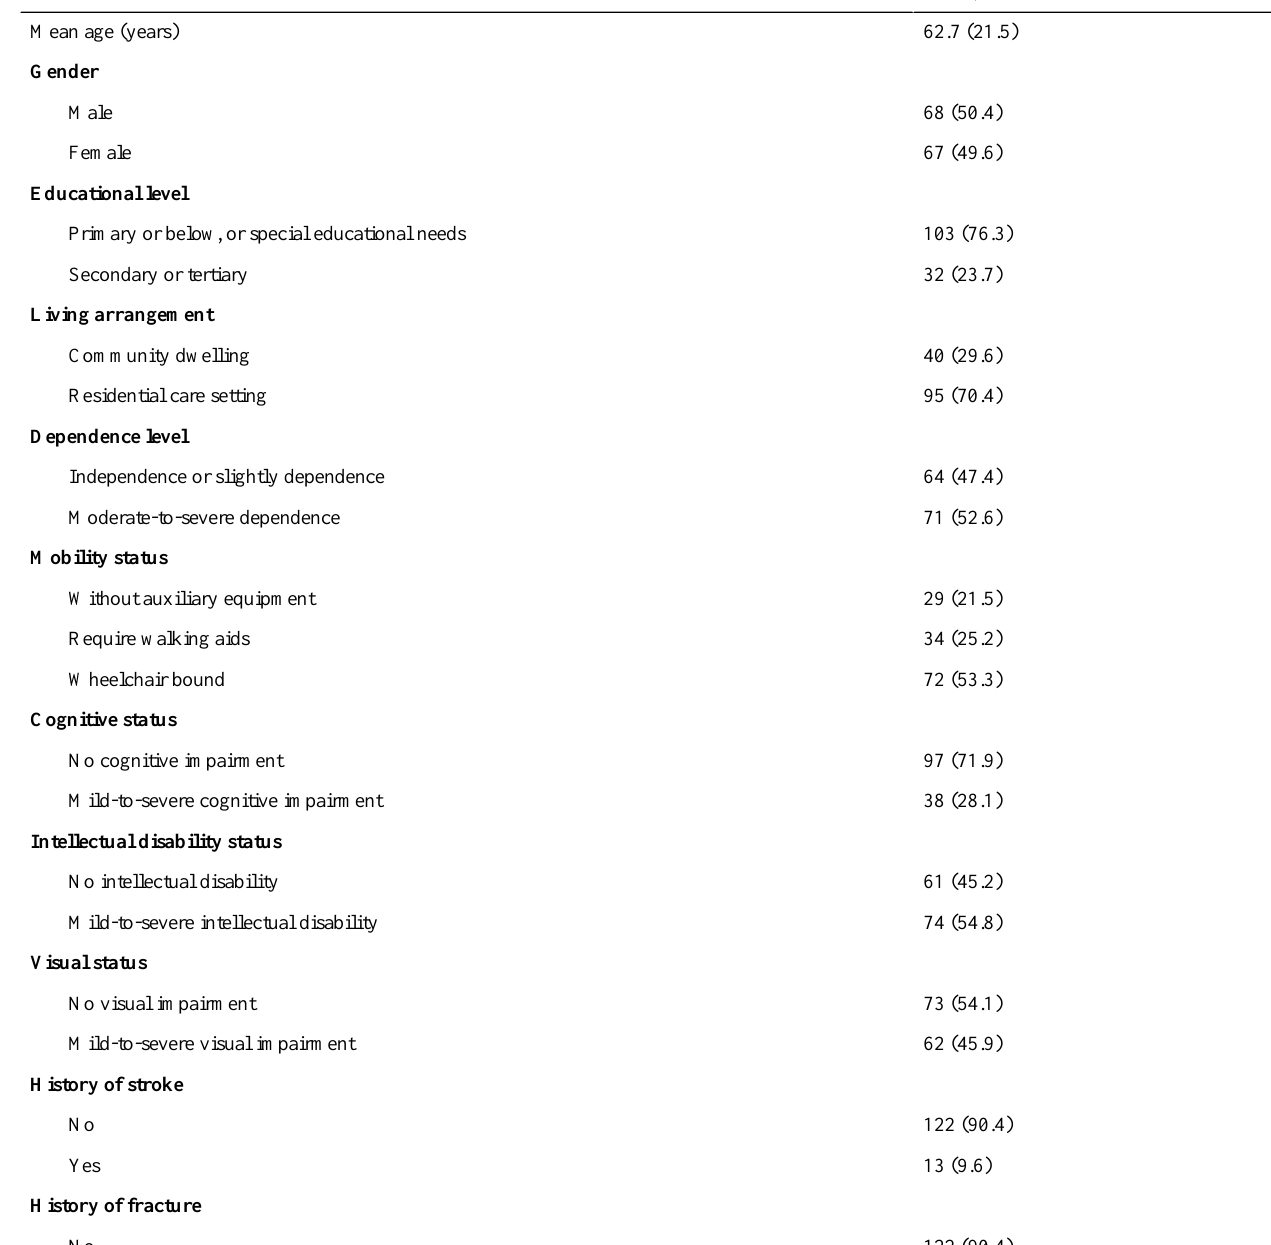
Table 3. Baseline characteristics of the participants